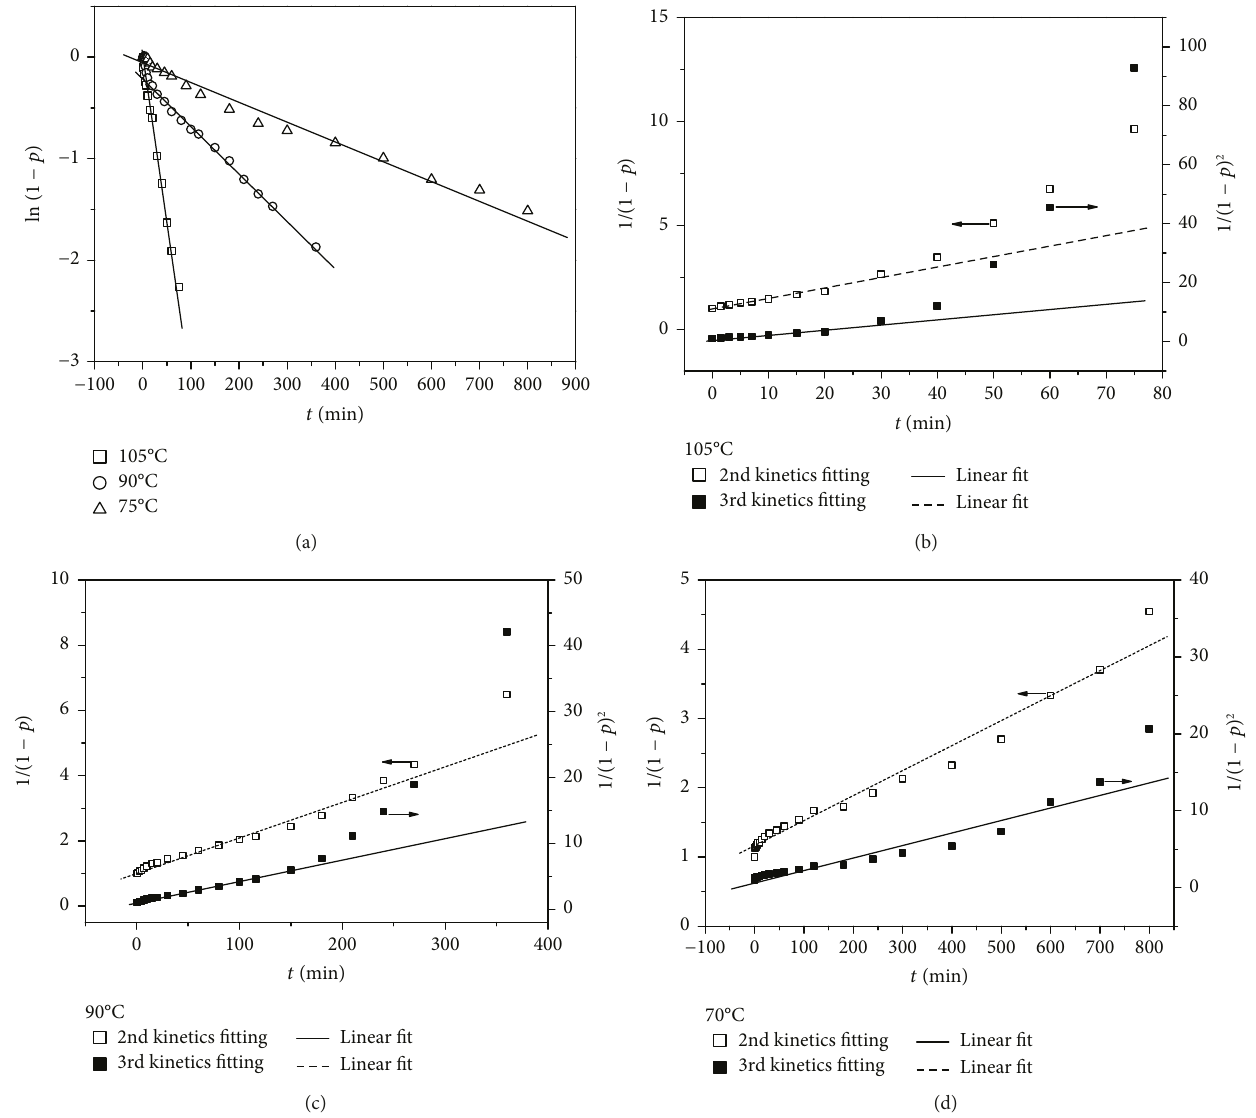
Figure 6: First-order rate law for PSU with 150ppm TEA at di ff erent temperature (a). Second-order rate law and third-order rate law for PSU with 150ppm TEA at 105 ° C (b), 90 ° C (c), and 75 ° C